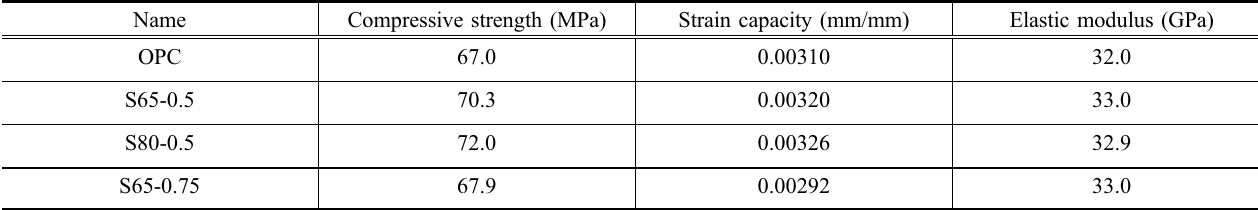
Table 5 Summary of compressive properties (at 28